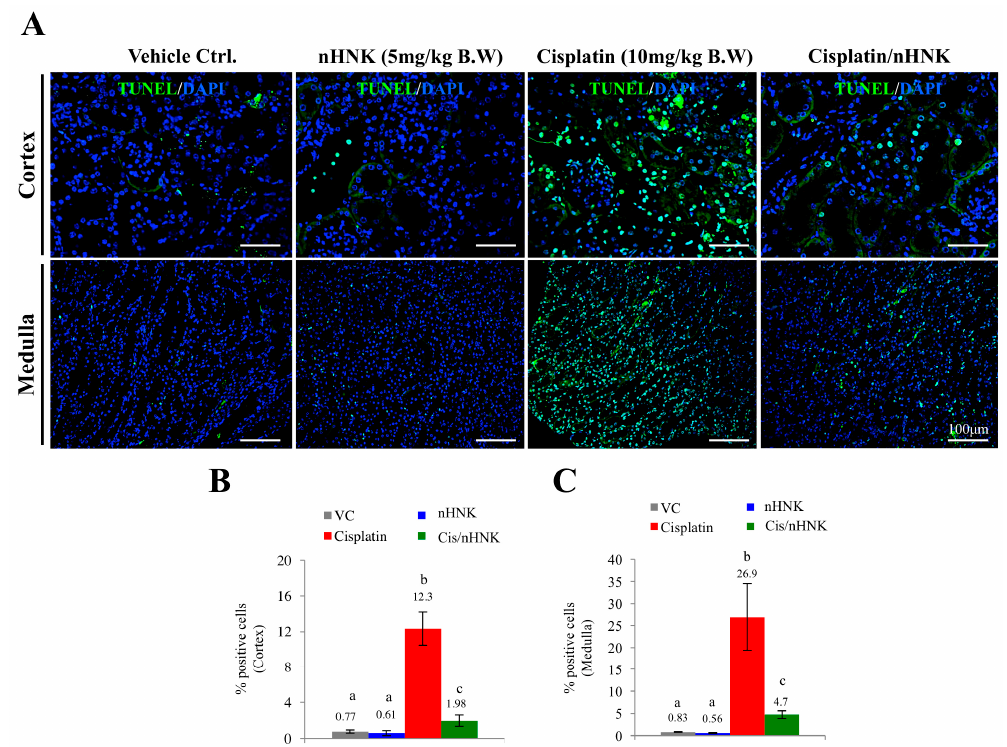
Figure 6. Evaluation of honokiol e ff ects on cellular apoptosis in kidney of cisplatin-injured animals. TUNEL assay was used to evaluate the level of cellular apoptosis. ( A ) In both cortex and medulla, minimal amounts of apoptotic cells were observed in control and nHNK alone groups (less than 1% in these conditions, B , C ). A dramatic increase of apoptotic cells was detected in both the cortex (12.3%, B ) and medulla (26.9%, C ) regions of the kidney, however, when nHNK was given to cisplatin-treated animals, significant decreases in apoptotic cells were observed (1.98% and 4.7% in the cortex and medulla regions, respectively).